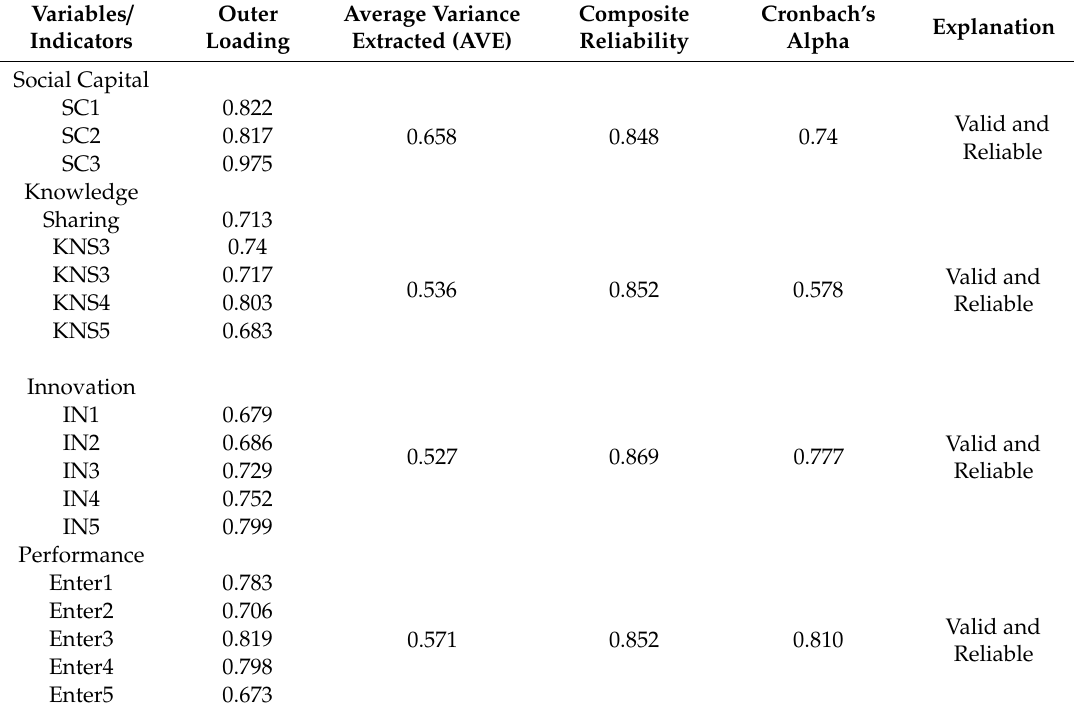
Table 2. Test validity and